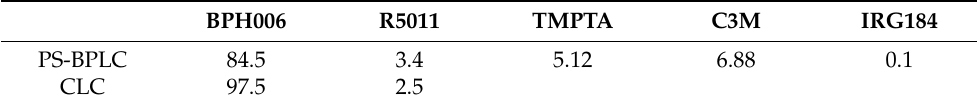
Table 1. Composition ratio of dual-wavelength LC filter (wt